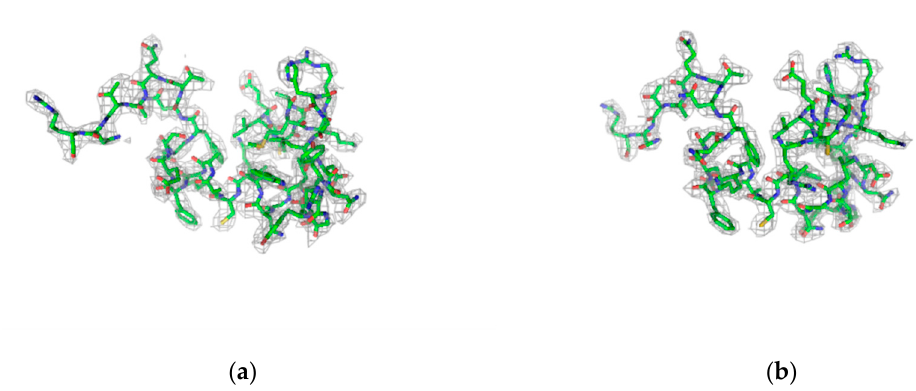
Figure 6. 2mF obs - DF calc electron density (contoured at 1 σ ) for residues 5–45 of lysozyme ( a ) for data collected at 2 kHz frame rate (dataset L12_50) ( b ) for data collected at 3 kHz frame rate (dataset L13_50).